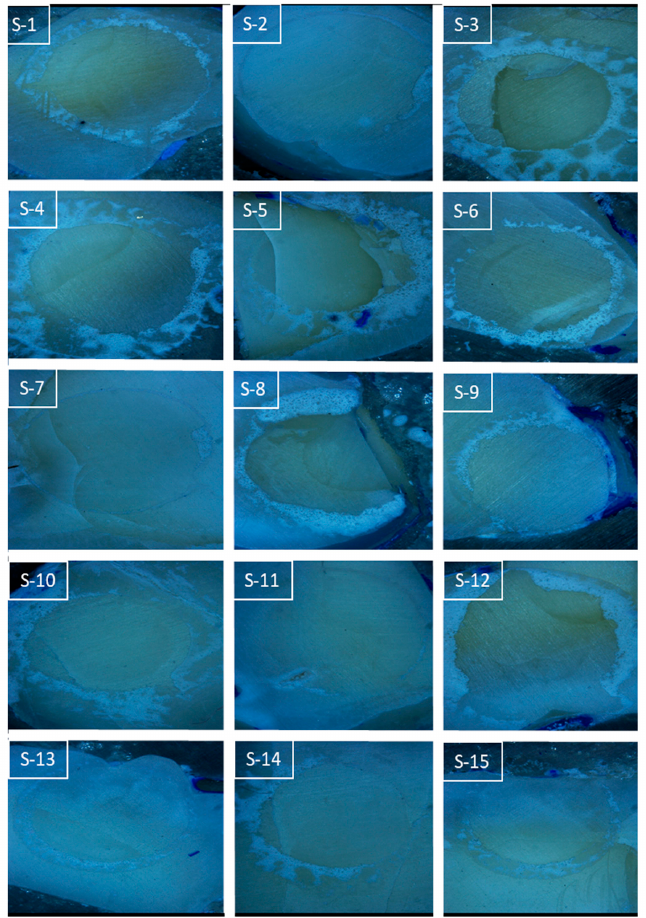
Figure 4. Microscopic analysis of the modes of failure n = 15 (Group I).